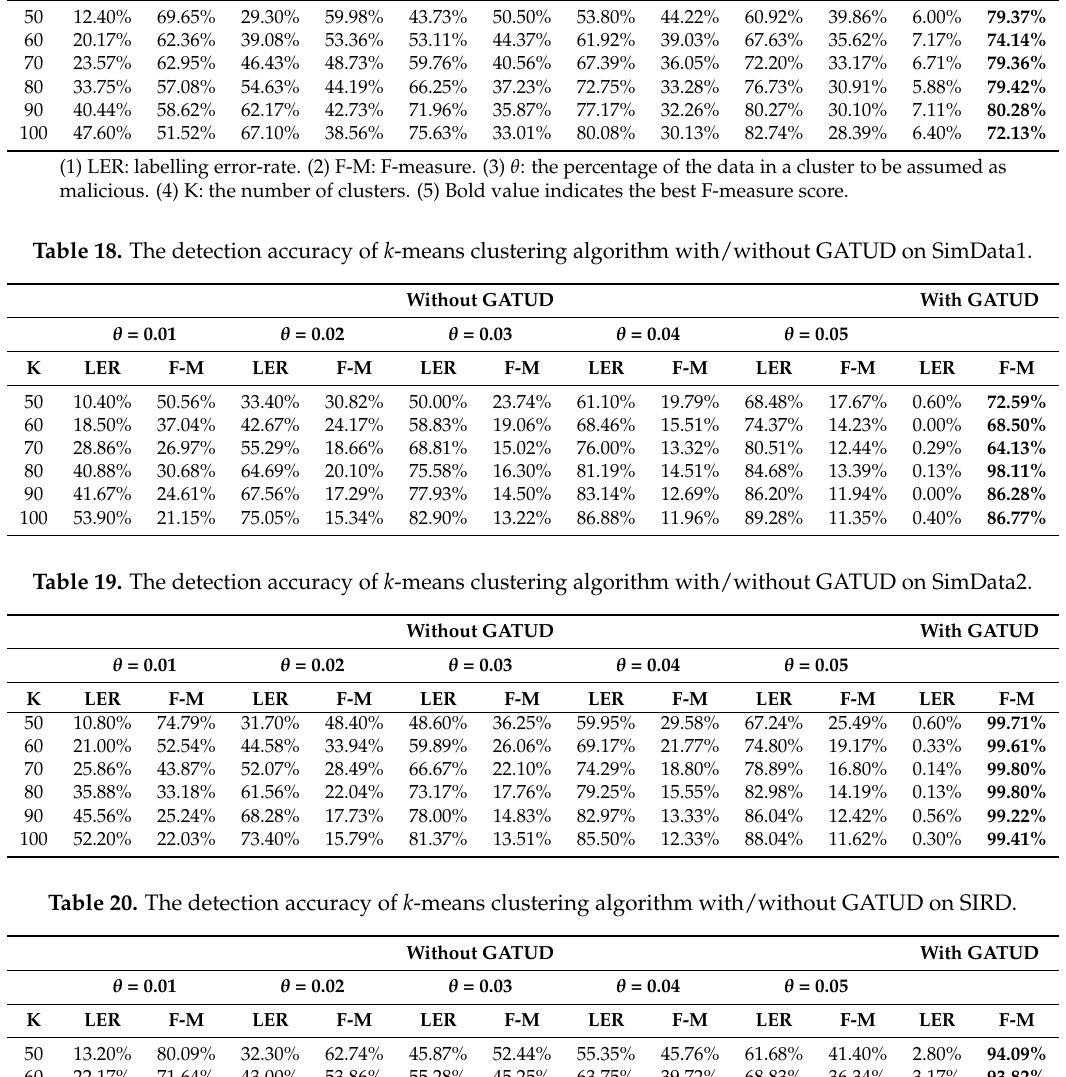
Table 17. The detection accuracy of k -means clustering algorithm with/without GATUD on DUWWTP. Without GATUD With GATUD θ = 0.01 θ = 0.02 θ = 0.03 θ = 0.04 θ = 0.05